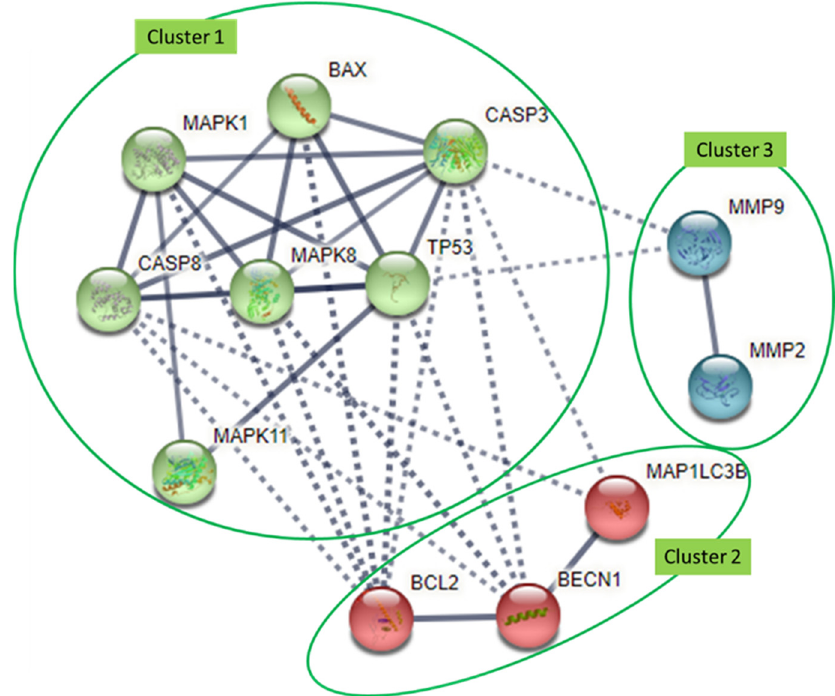
Figure 2. Protein-protein interaction (PPI) networks of molecules targeted by at least 5 flavonoid compounds were generated by STRING software (15 nodes, 47 edges). The nodes represent proteins, and the protein structures are visible in the nodes. The lines connecting the nodes indicate the association between the proteins (solid lines: association of proteins between same cluster; dotted lines: association of proteins between different clusters). The thicker the line, the higher the degree of confidence prediction of the interaction. K-means clustering tool in this software was used to group molecules into three distinct clusters. Those shown in green (cluster 1) are related to cell proliferation, differentiation and apoptosis, those shown in red (cluster 2) are involved in cell apoptosis and autophagy, and those shown in blue (cluster 3) are related to cell migration and invasion.